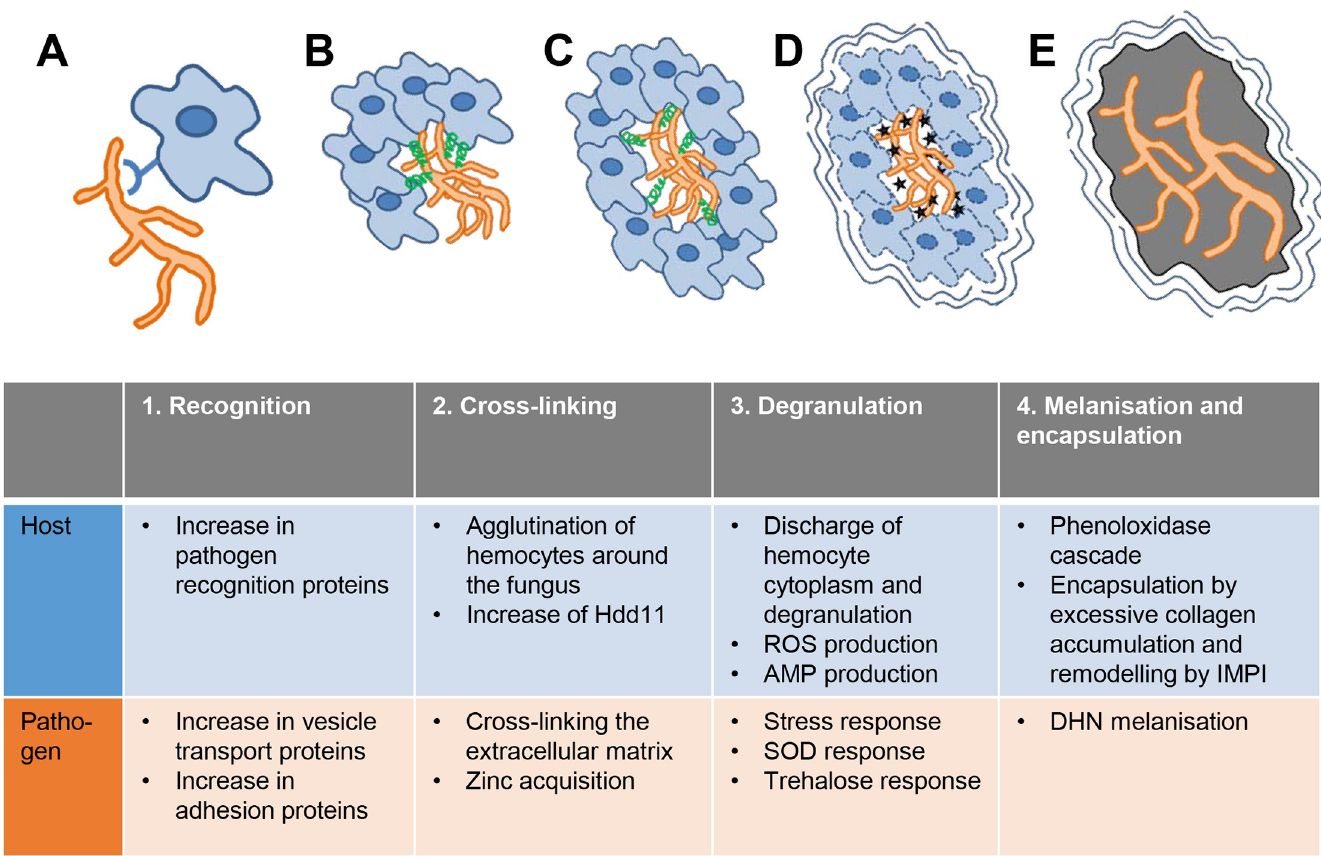
Fig 6. Model of grain formation over time with the most important processes of host and pathogen. A. M . mycetomatis is recognized by the G . mellonella host via pathogen recognition proteins. M . mycetomatis increases vesicle transport and adhesion proteins are displayed on the surface attaching itself to the host. B. Hemocytes will agglutinate around the fungal hyphae and Hdd11 production is increased resulting in crosslinking of the hemocytes and attaching to the fungus. The fungus itself will secrete Asp f2, a zincophore to acquire zinc and to cross link the extracellular matrix. C. Hemocyte cytoplasm will be discharge and degranulation occurs which elevates ROS production and the secretion of AMPs at the granule. The fungus will react by producing SOD and trehalose. D. Melanin will be produced by the host and by the fungus and a capsule is formed surrounding the grain. E. In the last stage, no hemocytes are found within the grain, they are all lysed and the extracellular matrix is completely